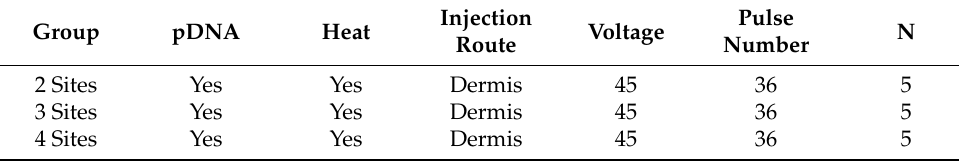
Table 4. Scalability of Factor IX